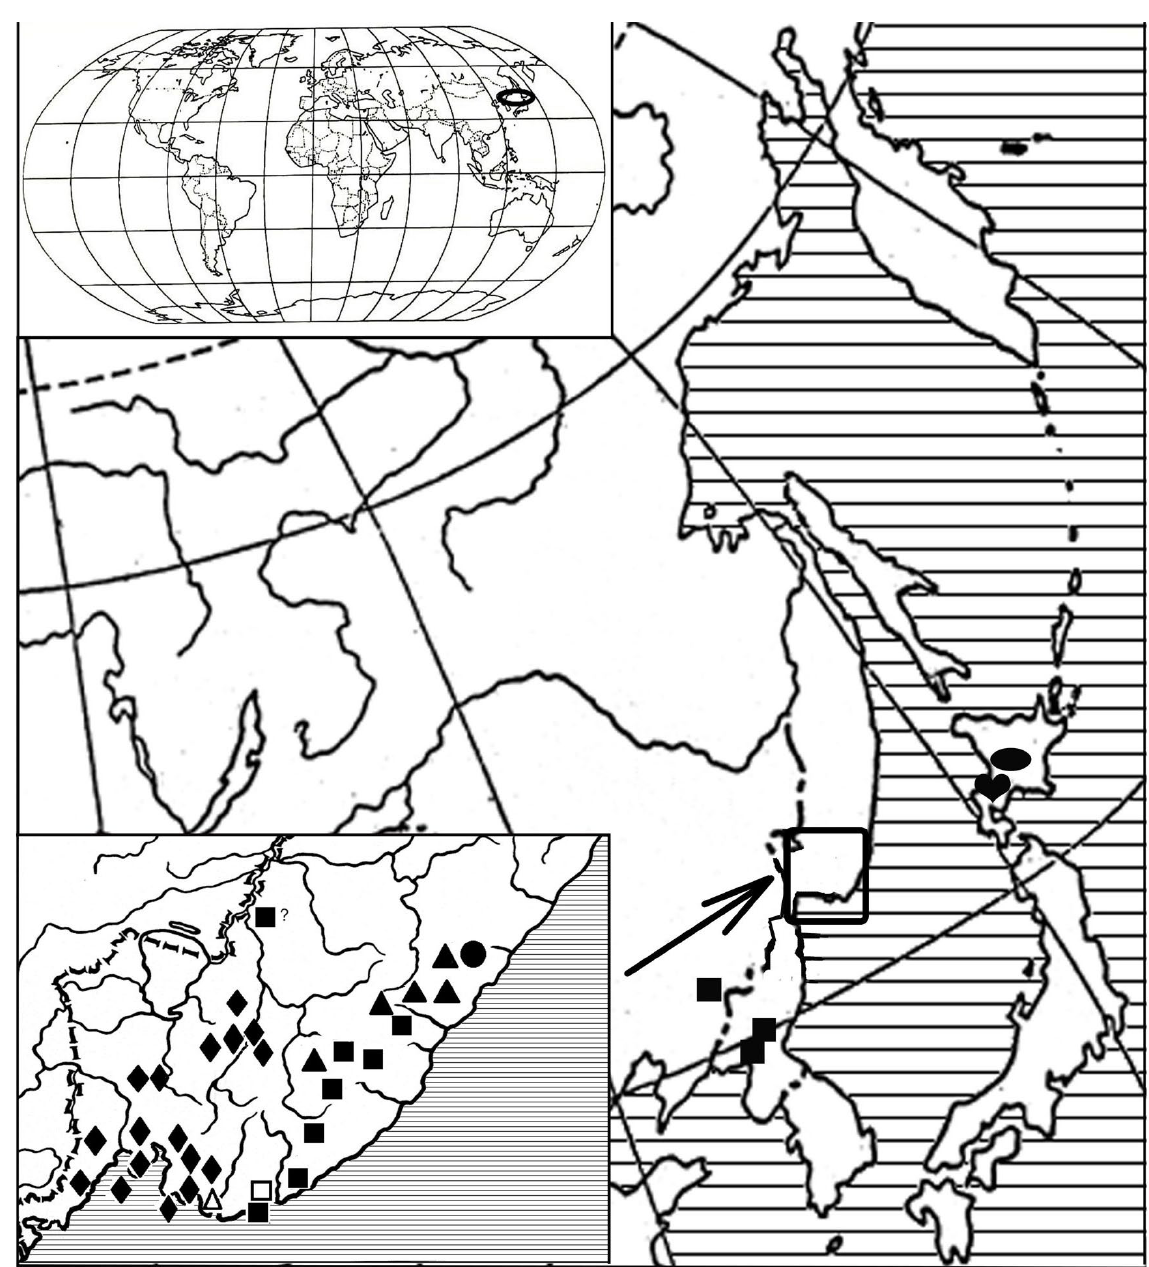
Fig. 13. Distribution of species of the genus Levizonus Attems, 1898. Filled square: L. circularis Takakuwa, 1942. Filled circle: L. distinctus Mikhaljova, 1990. Open square: L. laqueatus Mikhaljova, 1981. Open triangle: L. nakhodka Mikhaljova sp. nov. Filled triangle: L. malewitschi Lokschina & Golovatch, 1977. Filled diamond: L. thaumasius Attems, 1898. Heart: L. takakuwai (Verhoeff, 1941). Oval: L. montanus (Takakuwa,